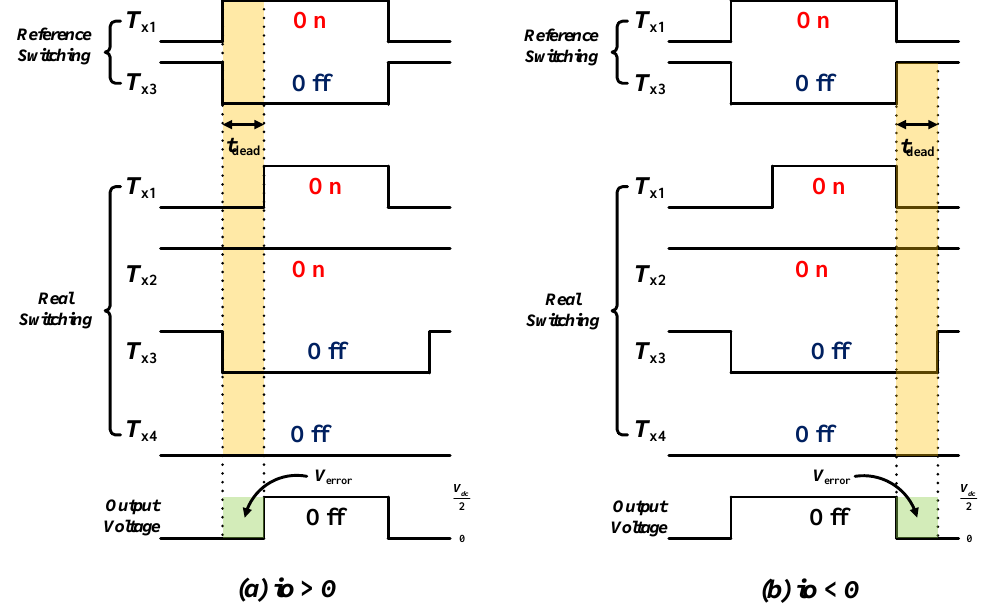
Figure 6. Switching state and output voltage during dead time.